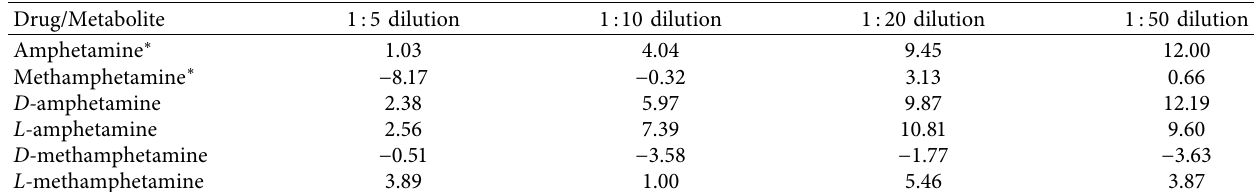
Table 7: Dilution study: percent diference from expected with a 4000 (2000) ng/mL standard diluted as indicated. All analytes are based at a 1:10